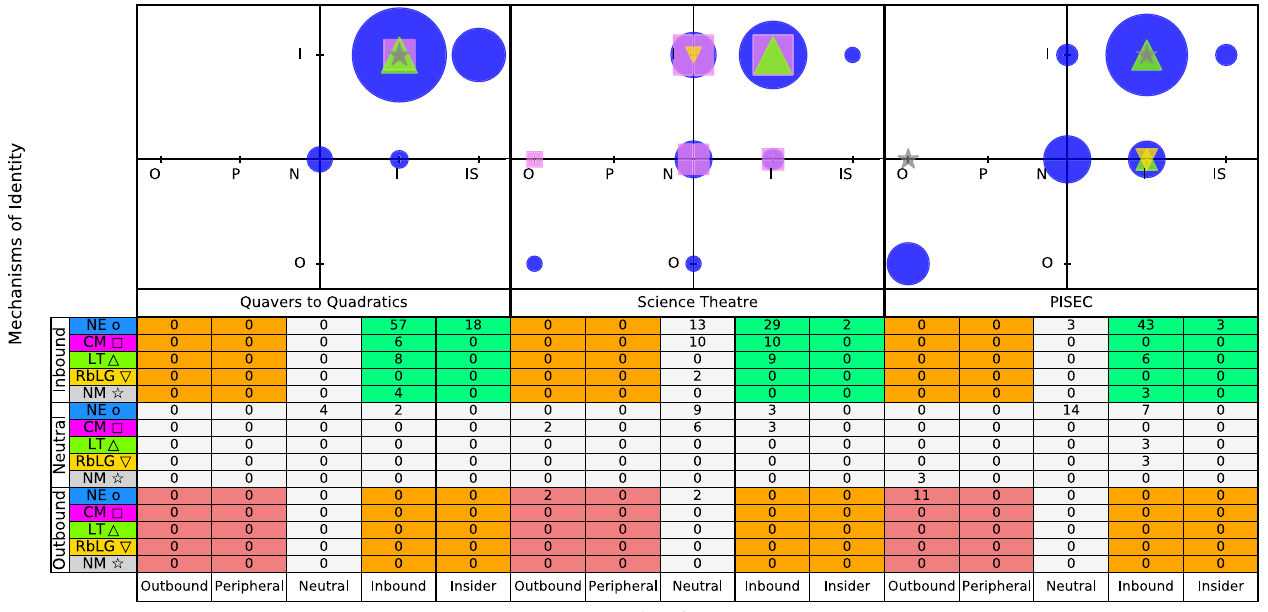
FIG. 5. The mechanisms of identity overlap with the mutuality of engagement. The frequency of the overlapping is represented by the size of the markers. The table mirrors the plot and shows the frequencies in each quadrant marked with different